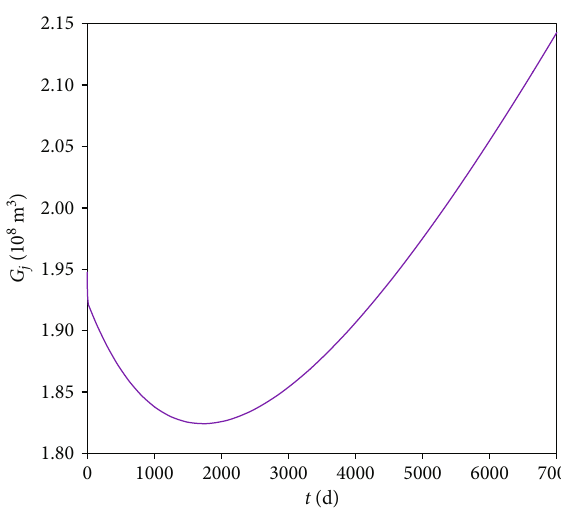
Figure 10: The static material balance relation of g ð p Case 1-1.